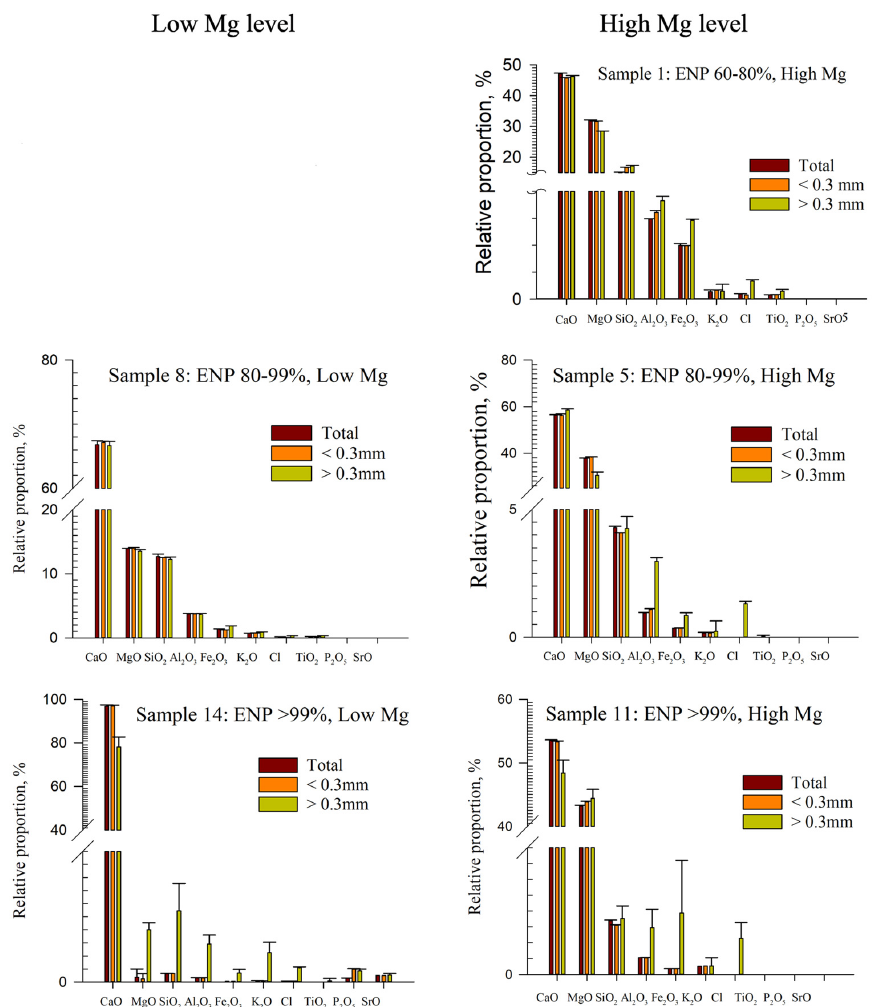
Figure 1. Chemical composition using X-ray fluorescence by dispersive energy from representative lime/corrective samples separated into three groups of efficiency neutralizing power—ENP and two Mg levels (low and high). The samples’ number correspond to the samples described in Table 1.